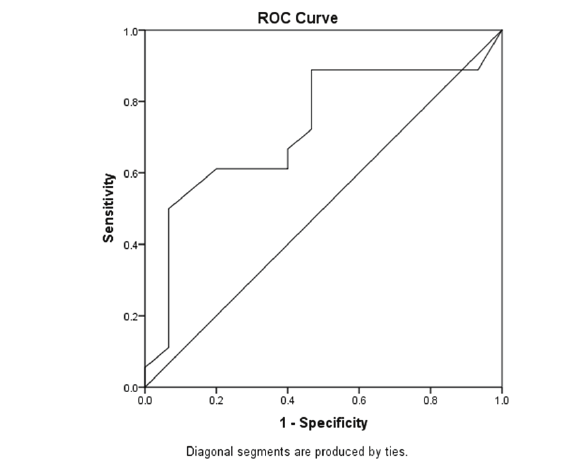
Figure 2: The prognostic value of the Barthel Index for a discharge